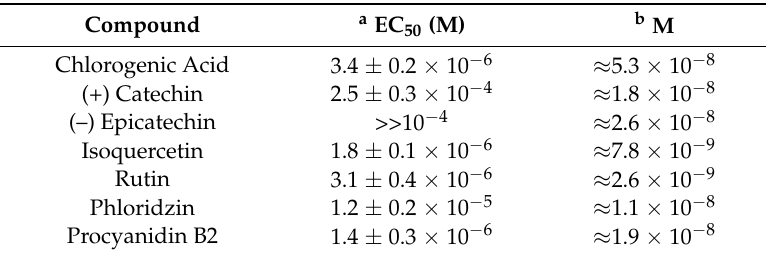
Table 2. WNT inhibitory activity of pure